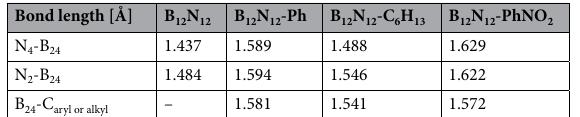
Table 1. Bond length on the selected atoms for the bare and grafted B12N12 nanocage cluster.